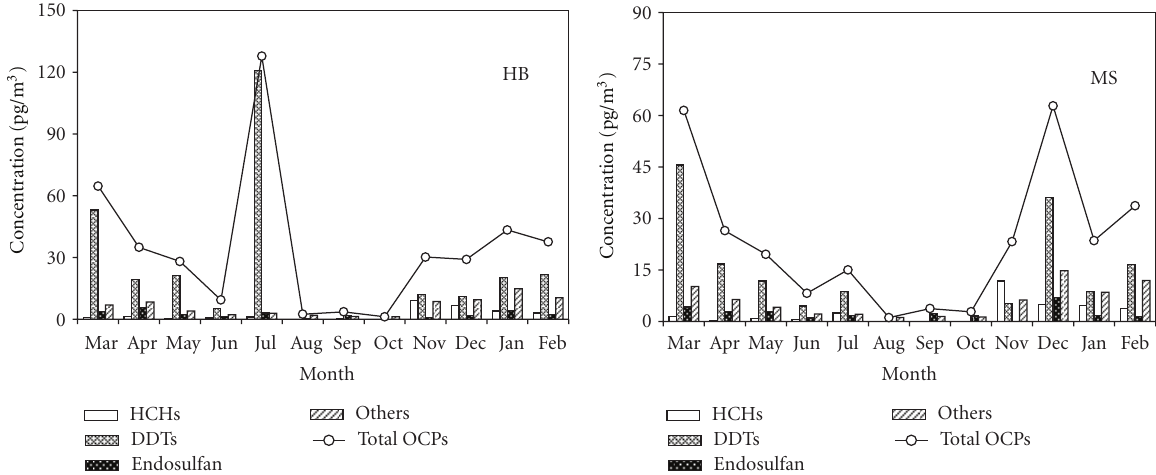
Figure 6: Temporal distributions of OCPs in the particle phase at the HB and MS sampling sites from March 2010 to February